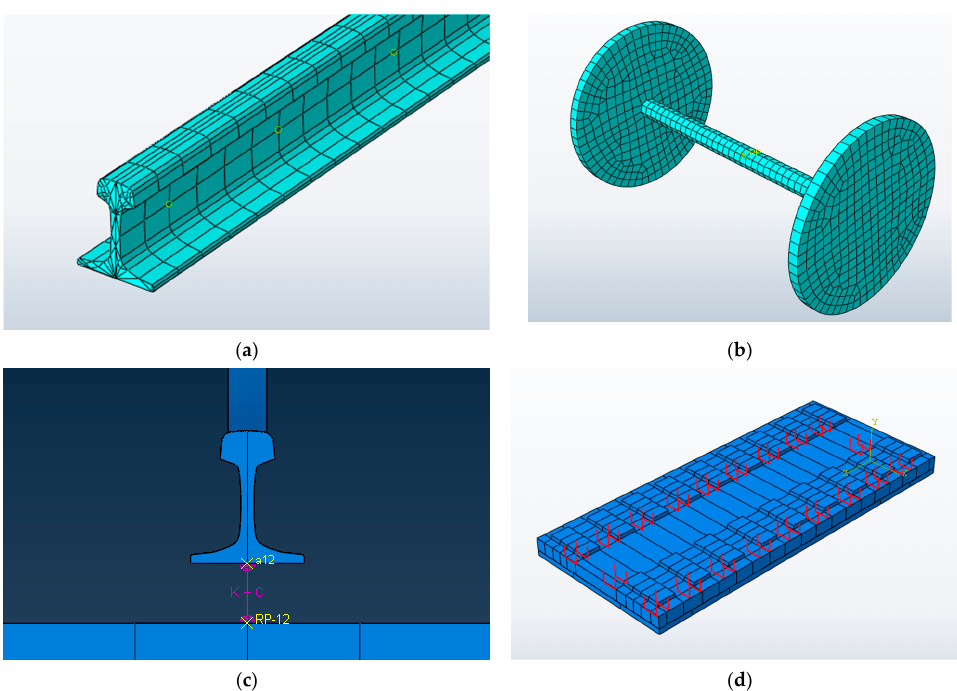
Figure 4. Finite element model of the main components: ( a ) rail finite element model; ( b ) wheelset finite element model; ( c ) finite element model of spring damping element; ( d ) finite element model of U-shaped ribs.